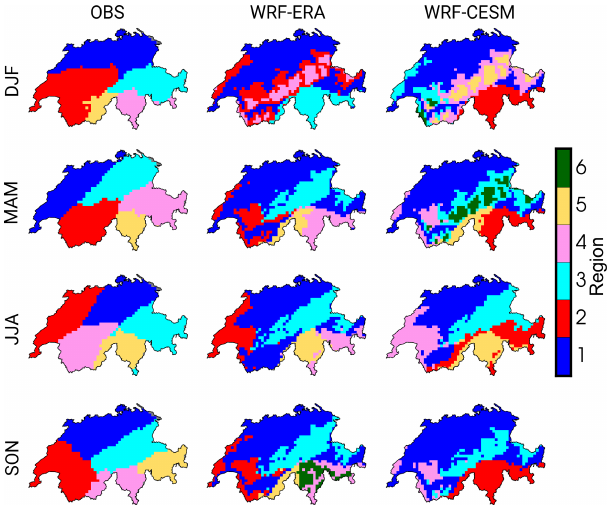
Figure 2. Regions obtained from the cluster analysis described in Sect. 3. The maps correspond to the 12 possible combinations, 3 for each dataset (OBS, WRF-ERA and WRF-CESM) and 4 for each season. Note that the colours are set arbitrarily as a label within the algorithm, so no one-to-one correspondence is implied between regions of the same colour in different